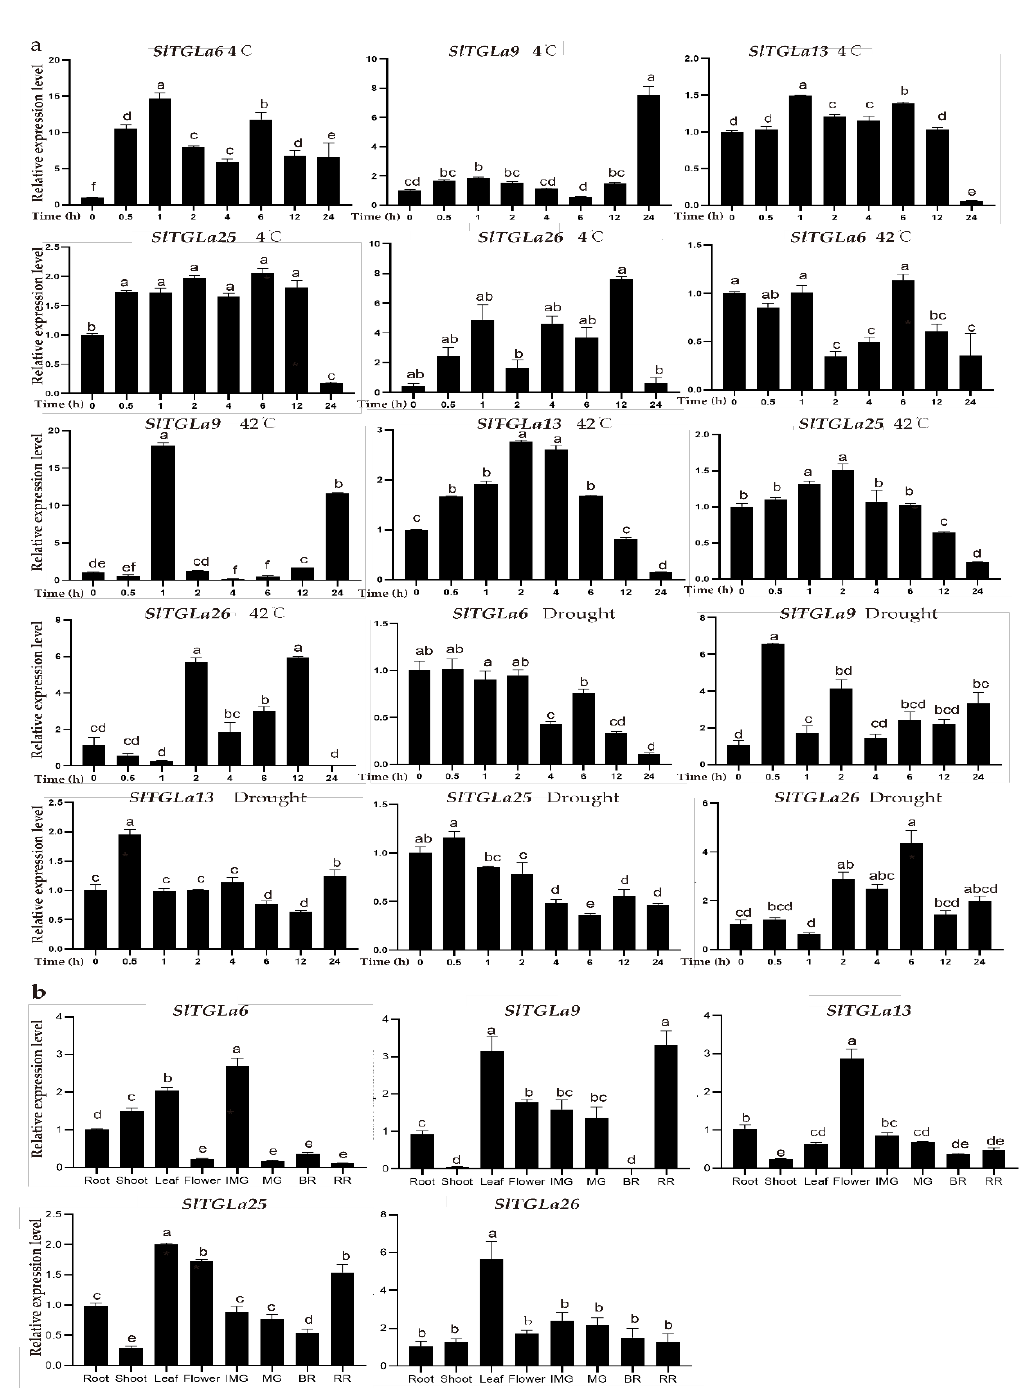
Figure 7. The qRT-PCR analysis of relative expression levels of SlTGL genes in 2-week old seedlings under abiotic stresses ( a ) and different organs of 3-month old plants ( b ). IMG, Immature fruit; MG, Mature green fruit; BR, Breaker stage fruit; RR, Red ripe stage fruit. Transcript analysis was performed at 0.5–24 h. The x-axis was time (h). Error bars indicate standard deviation (n = 3). Different letters above bars indicate significant differences in mean values under abiotic stresses or in different organs ( p < 0.05, one-way ANOVA analysis [Duncan’s multiple range test]).